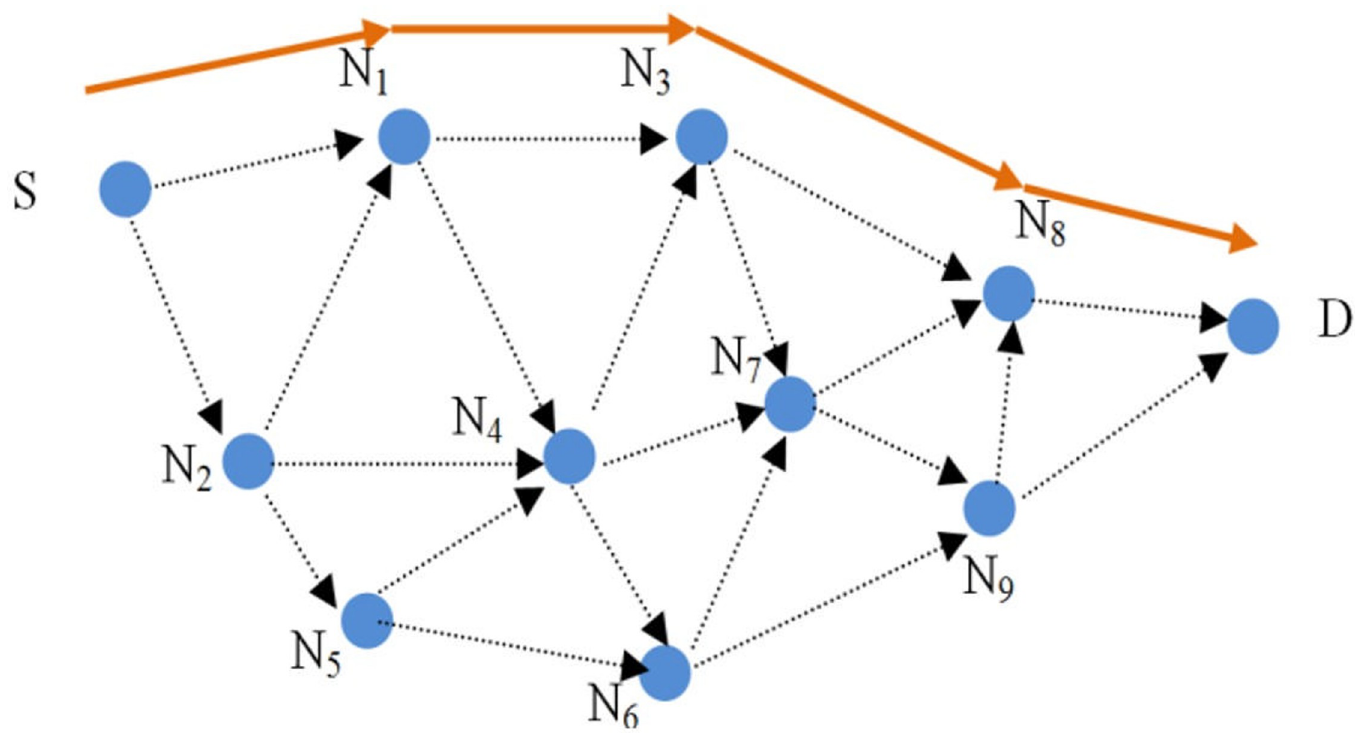
Fig 6. Sending time information and updating session